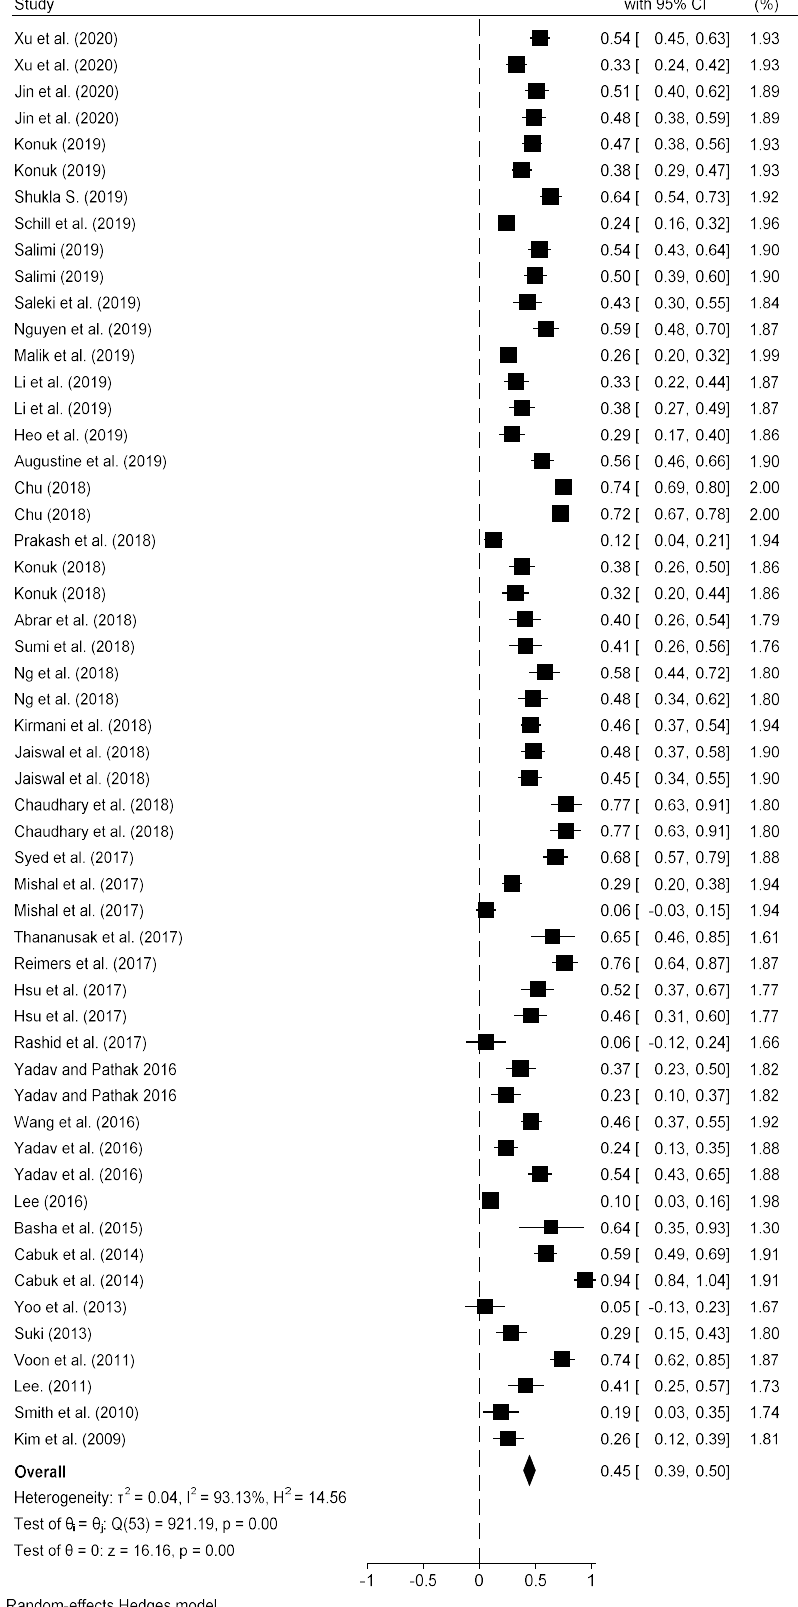
Figure 5. Meta-analysis of the association between environmental concern and consumer purchase behavior.